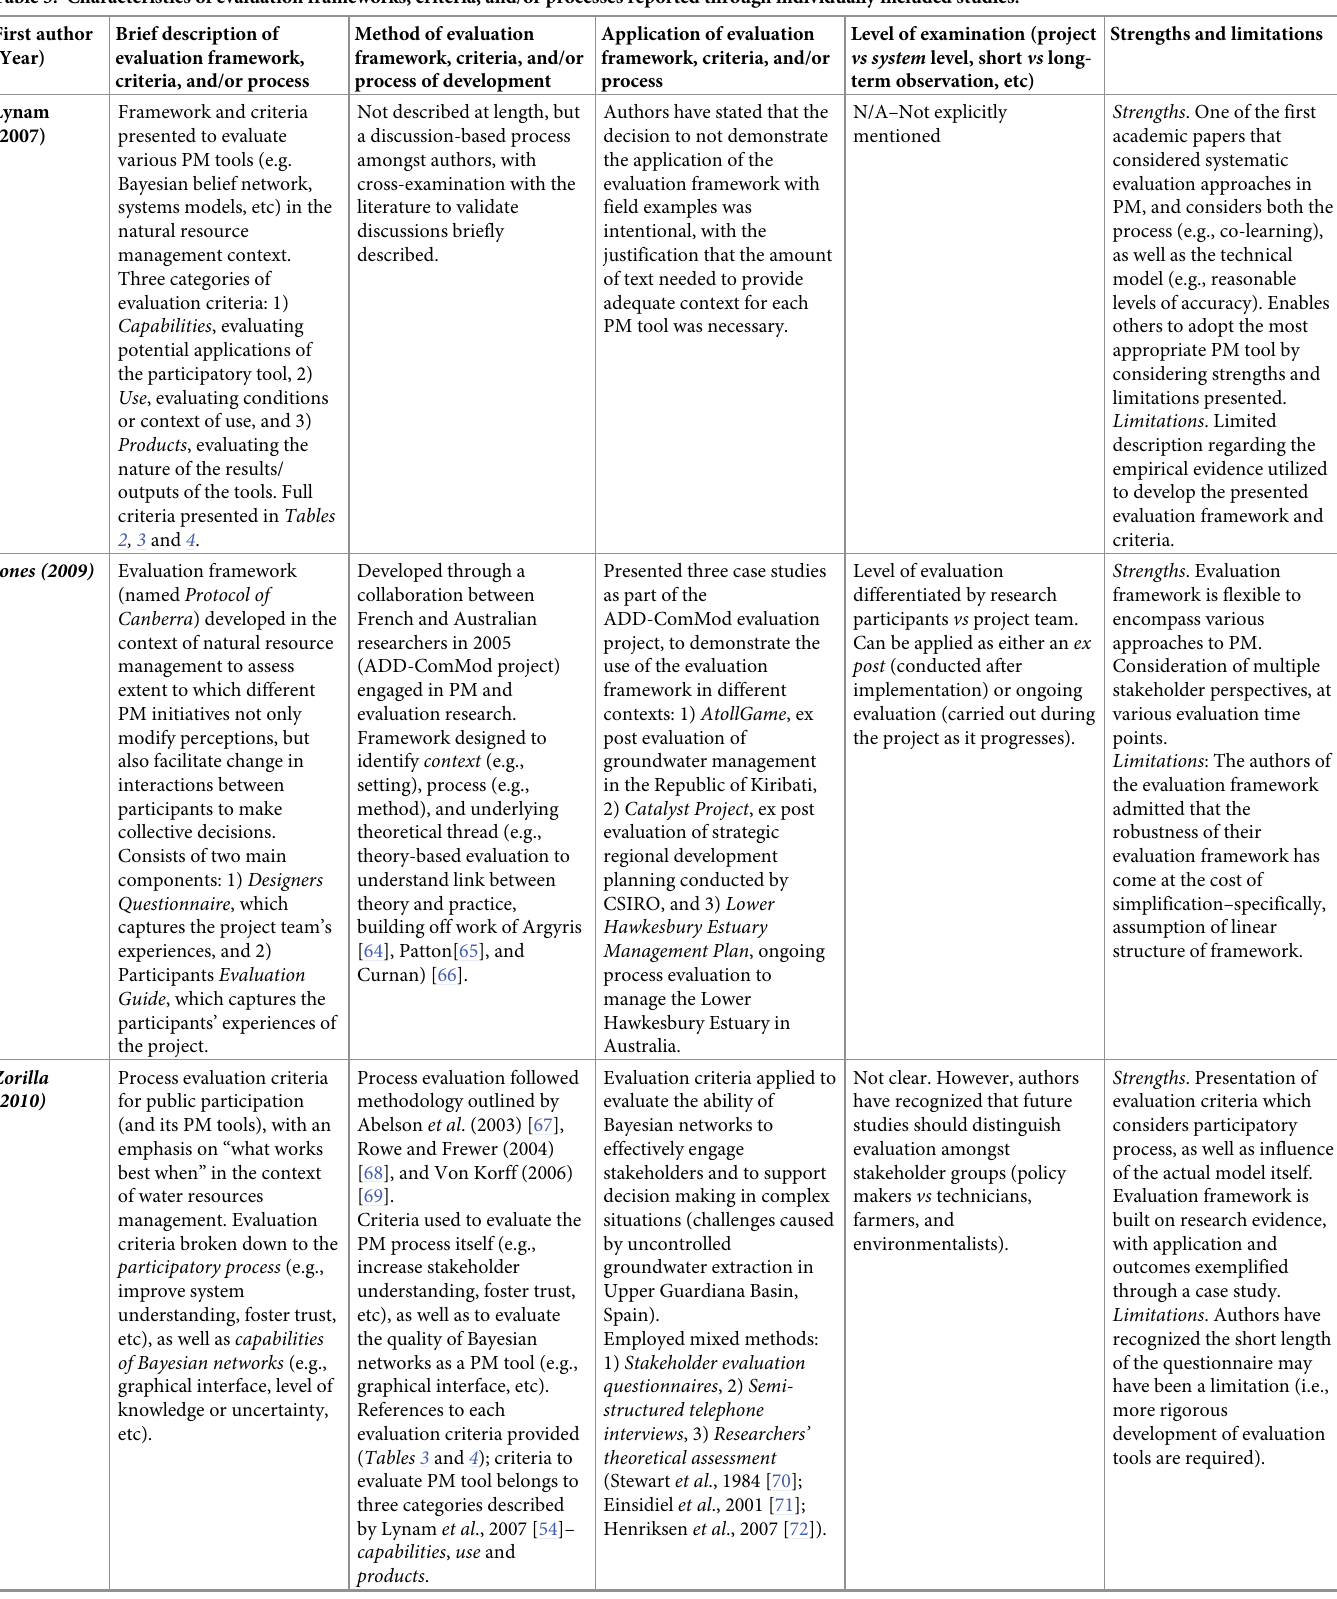
Table 5. Characteristics of evaluation frameworks, criteria, and/or processes reported through individually included